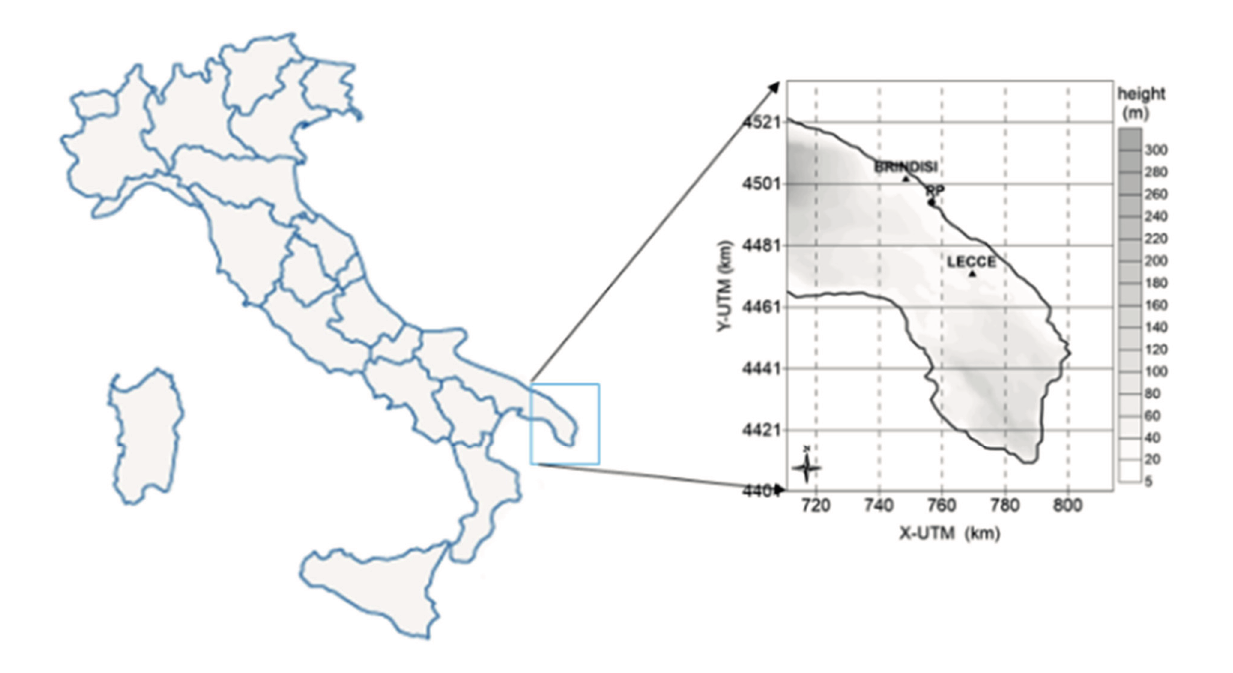
Figure 1. Area of